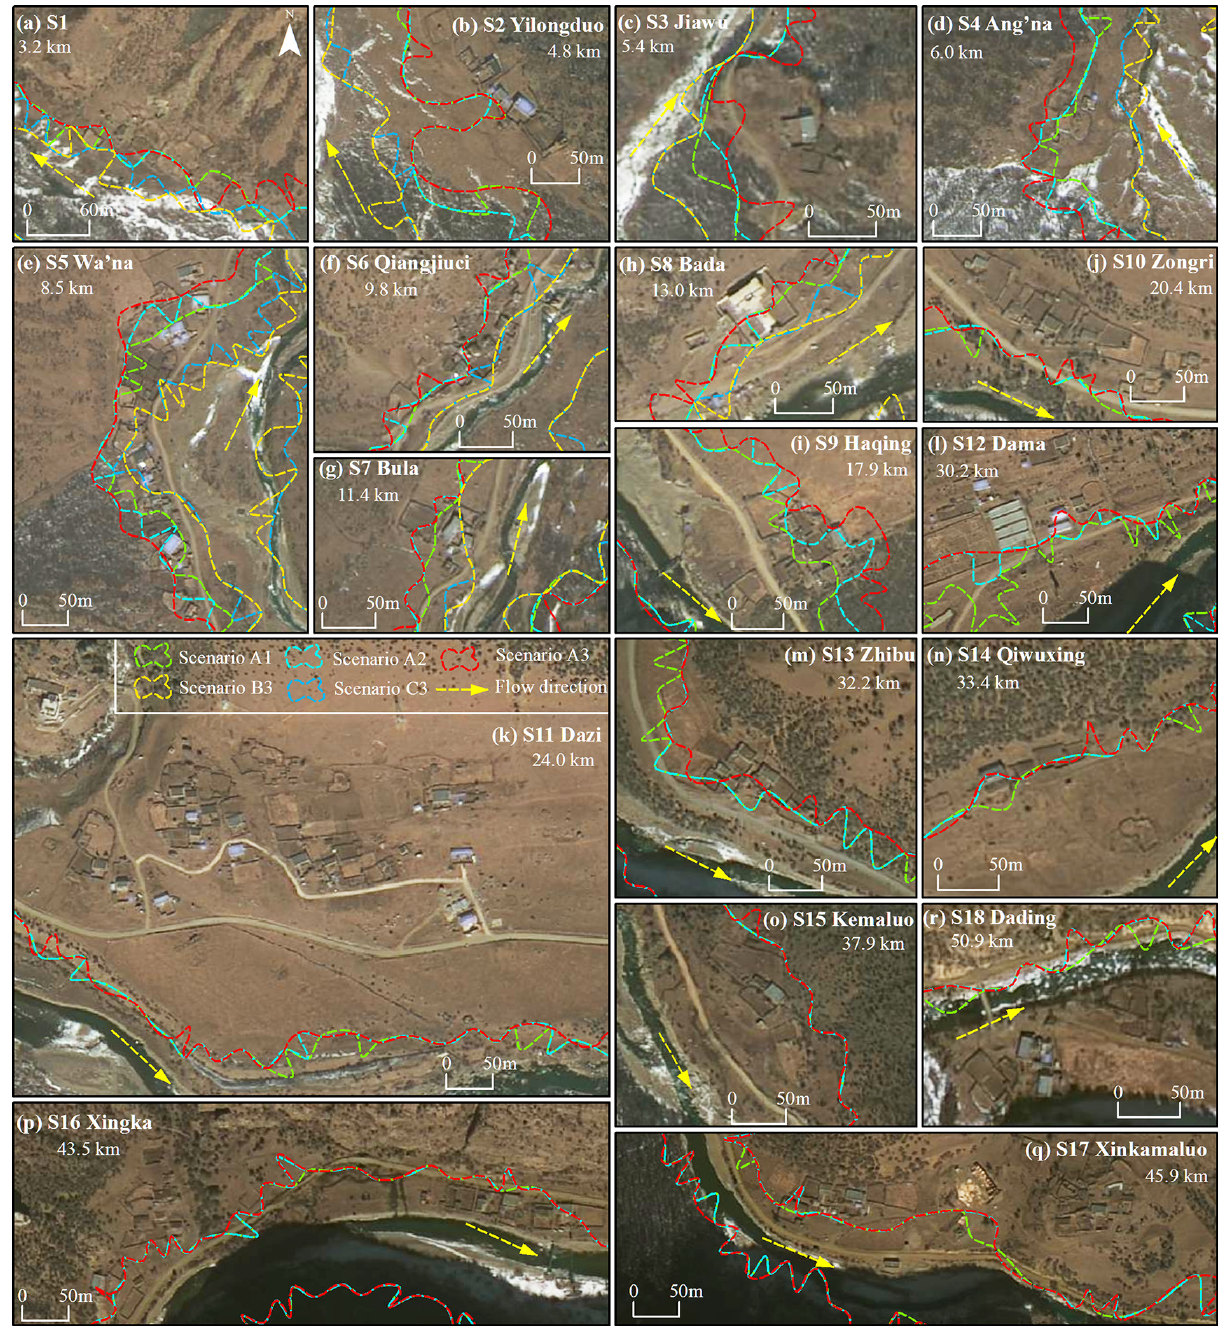
Figure 12. The potential threat of GLOFs to settlements and roads downstream under different ice avalanche and landslide scenarios (the background is the MapWorld